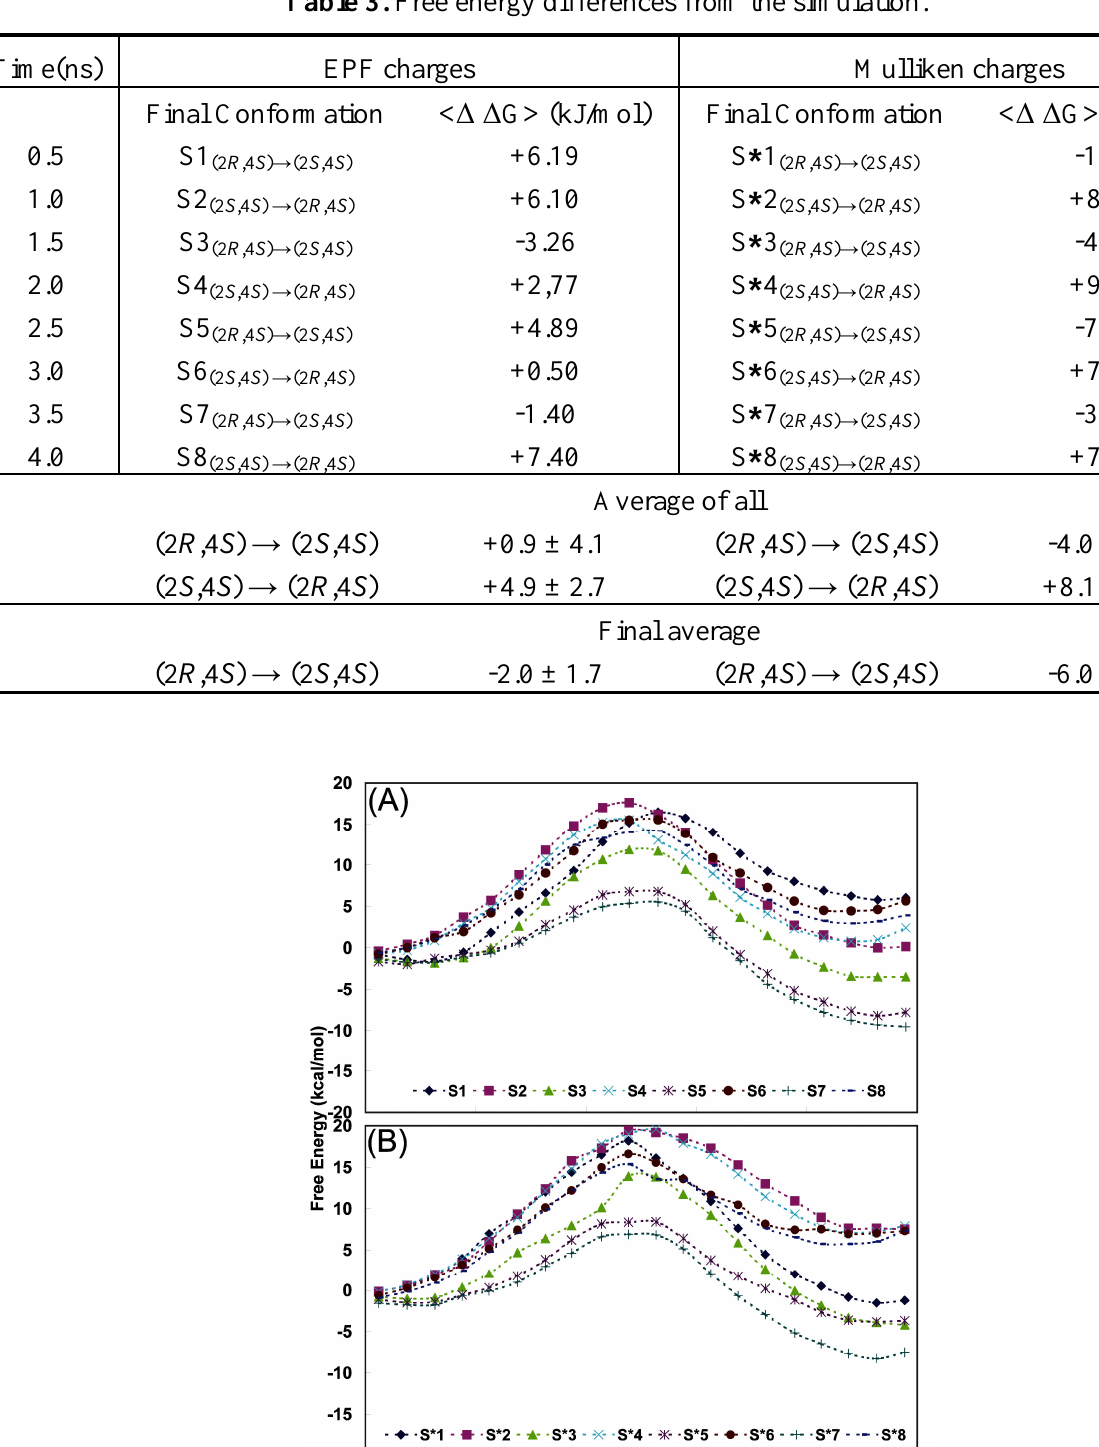
Table 3. Free energy differences from the simulation.